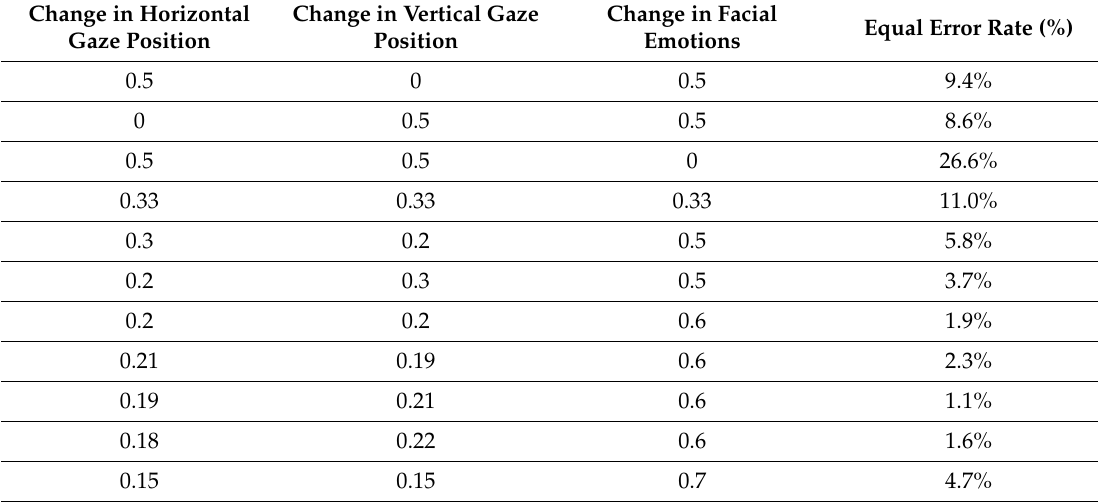
optimal weights based on weighted SUM rule are shown in bold.